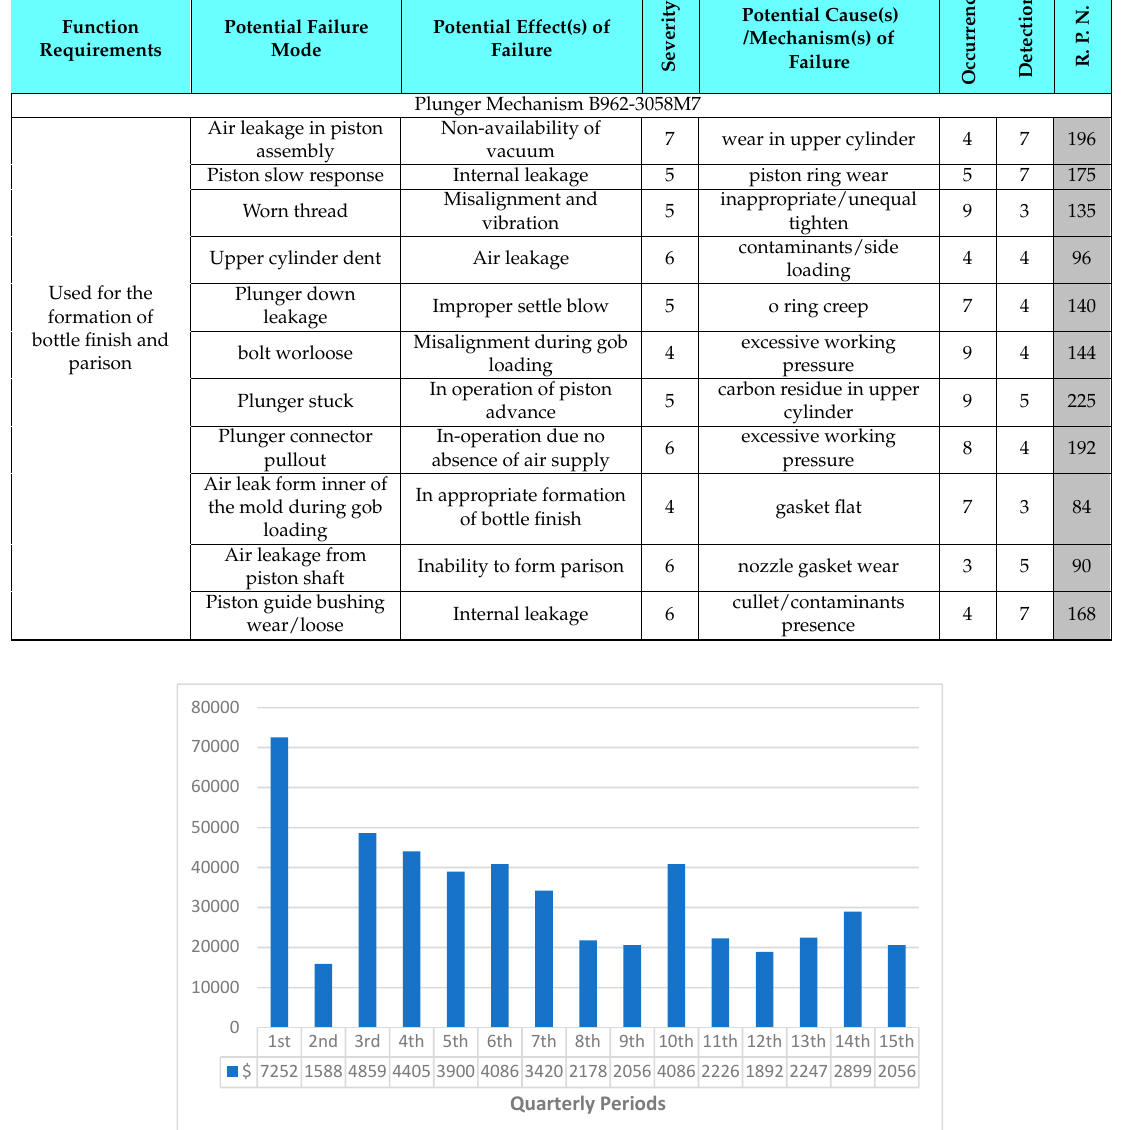
Figure 9. Loss in the cost of product not produced across quarterly periods for plunger mechanisms.